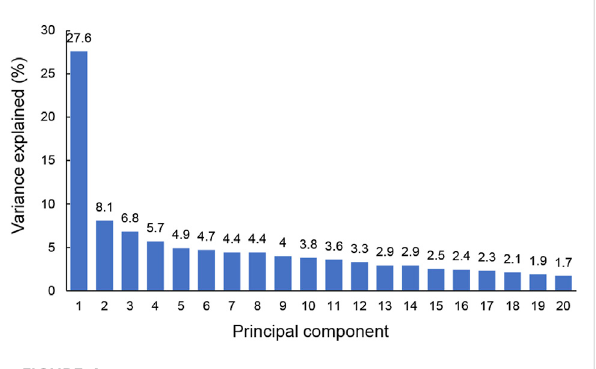
FIGURE 4 The explained variance of principal components for original training samples. The sum of the fi rst 16 principal components for variance explained could achieve more than 90%. view for the dimension of the data, the proportion of the variance within each principal component was shown (Figure 4). The results demonstrated that 16 components were needed to retain more than 90% of the original variance. In such a way, PCA reduced the dimension of the training samples from 20 to 16. The similarities and differences of the feature vectors in terms of the PCA